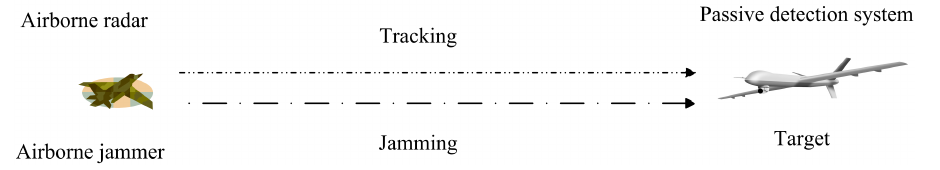
Figure 1. Combination of tracking and jamming at the target equipped advanced passive detection